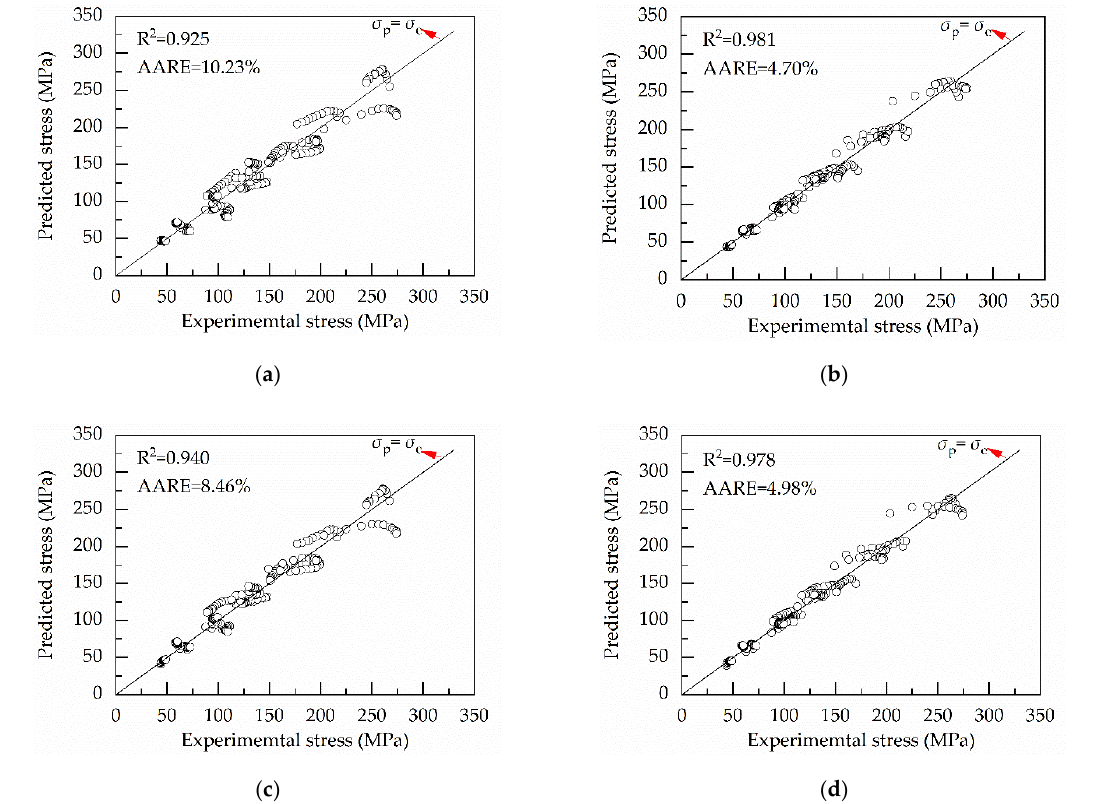
Figure 21. Correlation between the experimental stress and predicted flow stress values from the ( a ) osA-type equation; ( b ) msA-type equation; ( c ) oHS equation; ( d ) mHS equation.